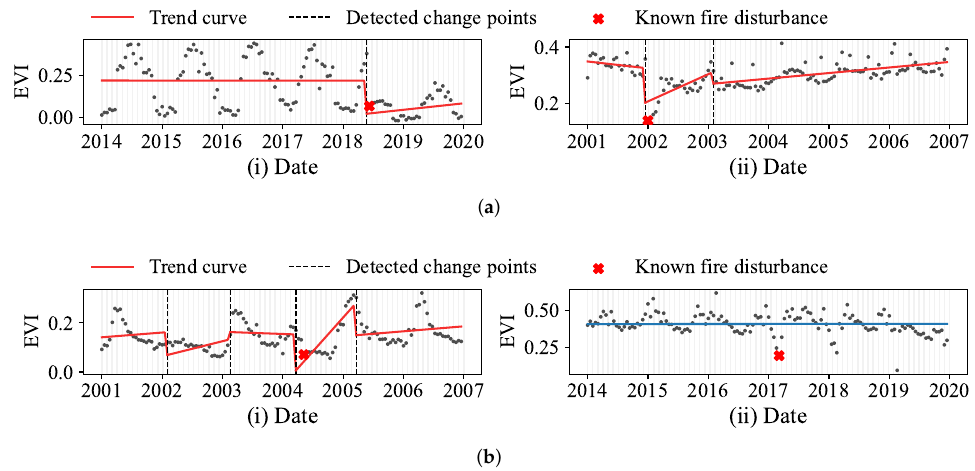
Figure 4. Partial detection results by BFAST model. ( a ) The detection advantages of the BFAST model: ( i ) The model can detect subtle forest perturbations; ( ii ) the model can detect insignificant trends. ( b ) The detection limitations of the BAFST model: ( i ) Non-stationary time series leads to detection of too many change points; ( ii ) the global change model is not obvious so that the change point cannot be